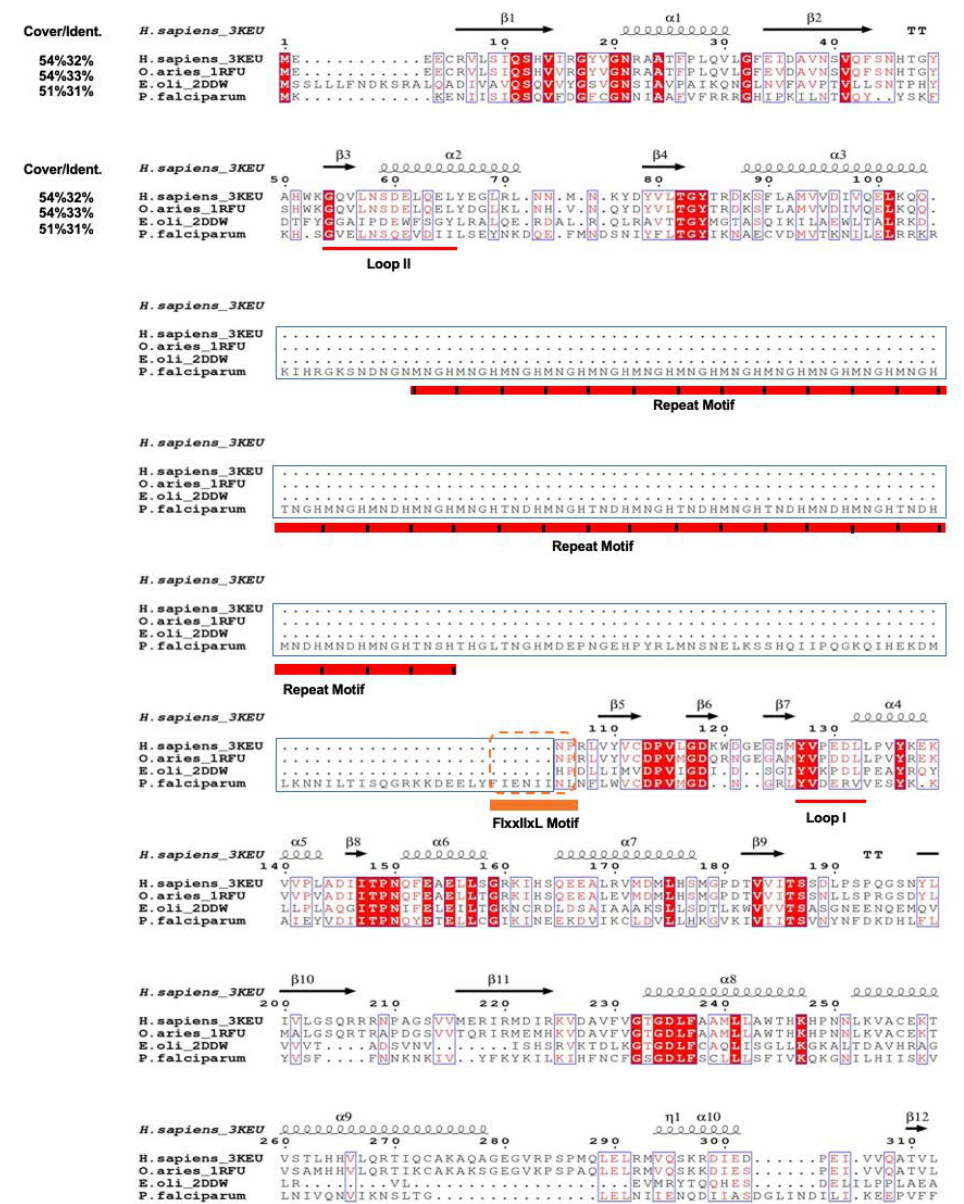
Figure 1. Multiple sequence alignment of Pf PdxK and the indicated homologs available within the PDB were generated using BLAST, T-Co ff ee and ENDscript 2.0. Pf PdxK exhibits a sequence identity of 30% over 54% of its sequence, with the remainder of the sequence present as an extended, high-degenerate insert consisting of multiple MNXH or TNXH repeats. Such repeats are frequently observed within the malarial genome (Figure S1 in Supplementary Materials), the Eh1-like motif FIxxIIxL was labeled in orange after the repeat